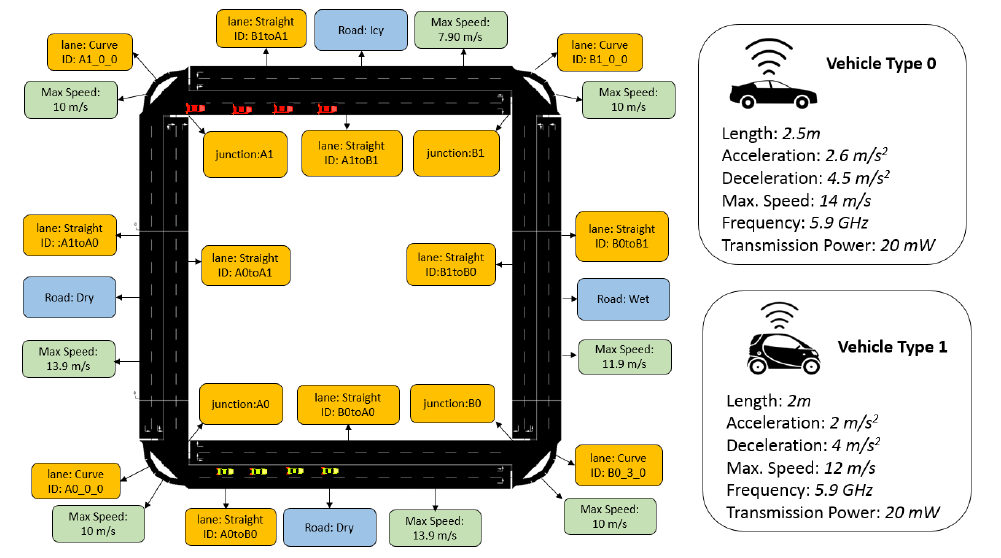
Figure 4. Road map and